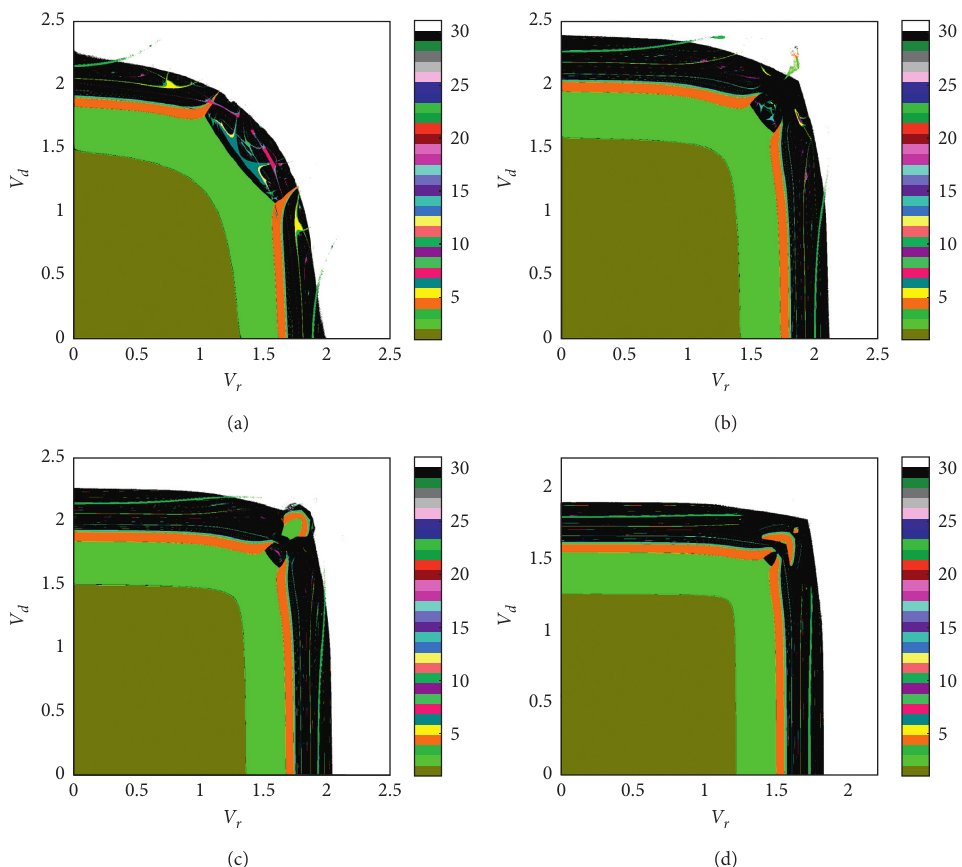
Figure 2: 2D bifurcation diagram of the system on the parameter plane ( v α � 0 .